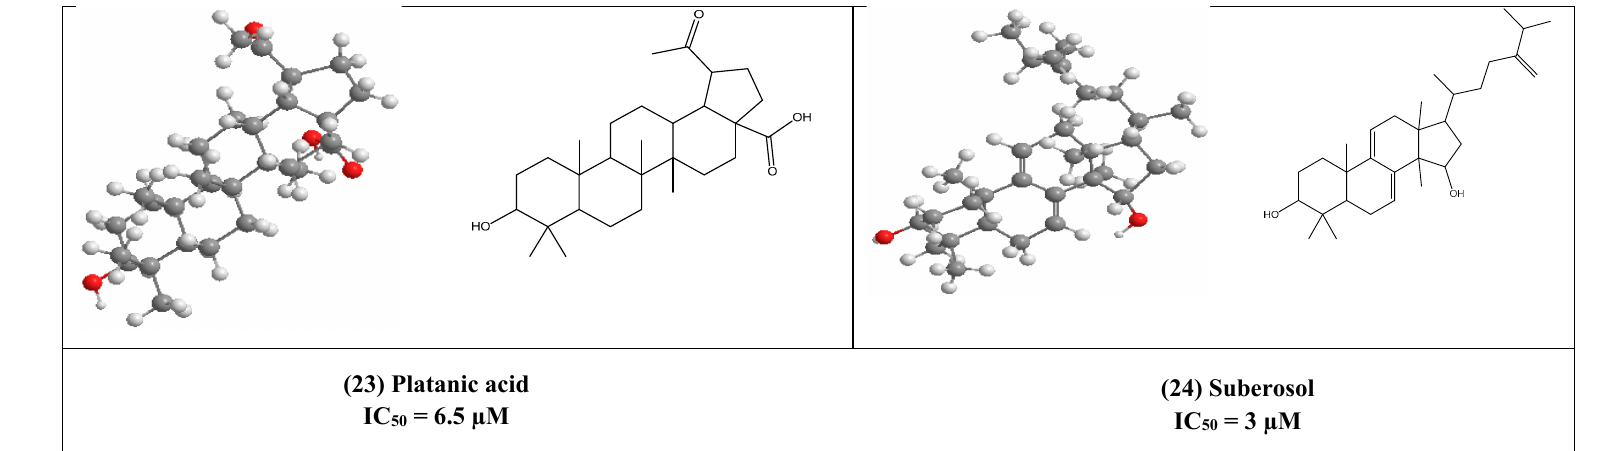
Figure 5. The 2D and 3D chemical structures of virus replication